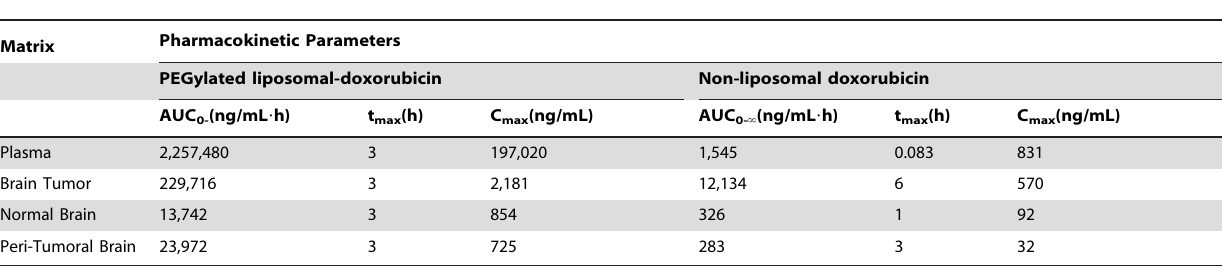
Table 1. Pharmcokinetic parameters for PLD and